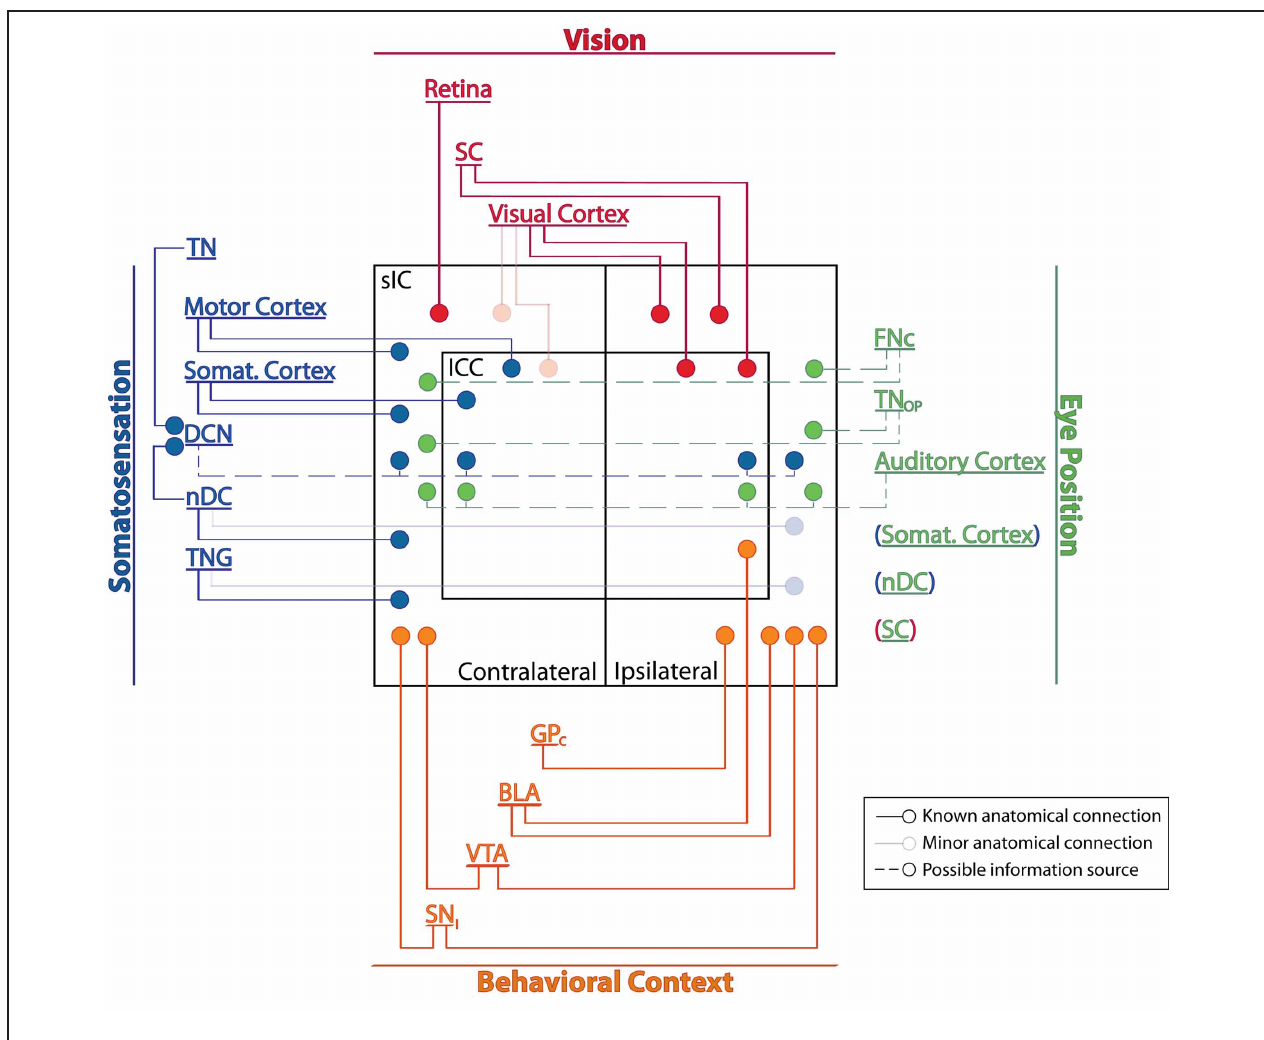
connections. Dashed lines are regions that, based on circumstantial evidence, may carry somatosensory or eye position signals to the IC. Somatosensory cortex, SC, and nDC may mediate more than one type of input and are listed under multiple headings; their connections are shown only once (indicated by parenthesis color). See Table 1 for